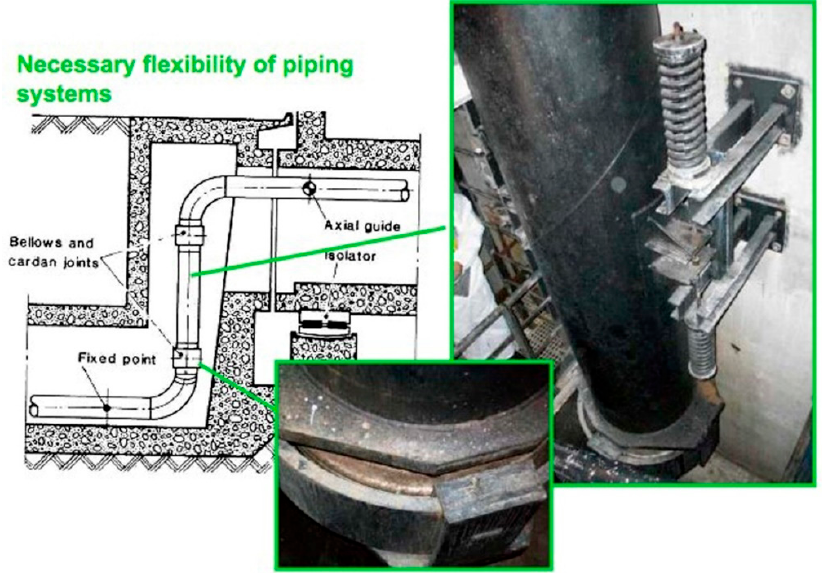
Figure 12. Flexible connections provided in piping systems that cross the seismic gap